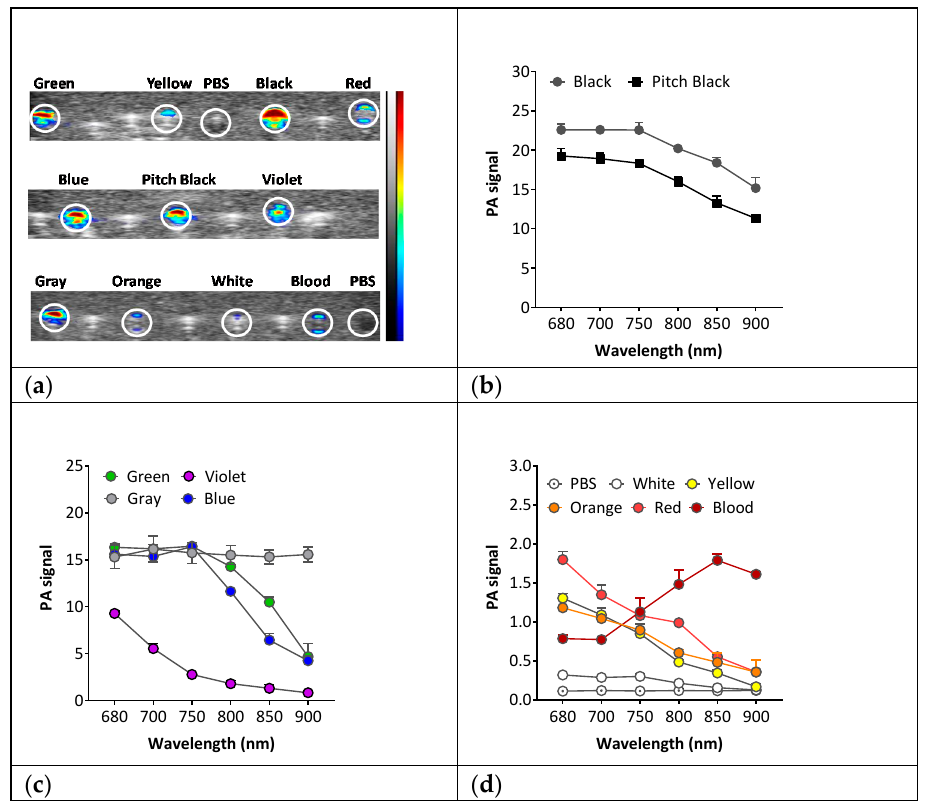
Figure 2. PAI of tattoo inks in vitro . ( a ) Pseudo-colorized PA signal maps (680 nm) of the ten tattoo inks along with blood and PBS filled channels. ( b–d ) Plots showing PA signal from 680–900 nm from the ten tattoo ink samples along with blood and PBS.